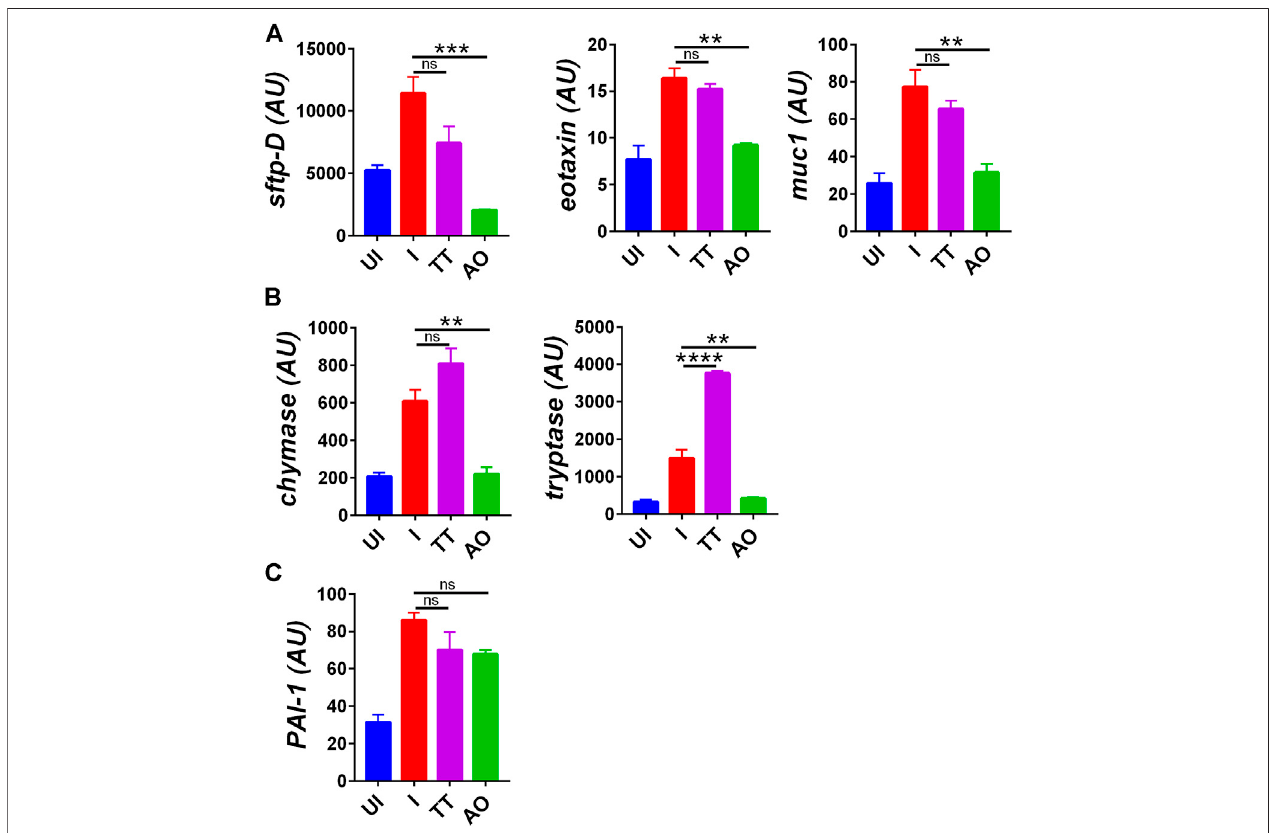
FIGURE 3 | Changes in mRNA expression of genes involved in lung injury upon AO or TT intranasal administration in hamsters infected with SARS-CoV2. Relative mRNAexpressionpro fi lingwascarriedoutinUI,I,TT,andAOlungsamplesfor (A) lunginjurygenes (B) mastcellactivationmarkers (C) thrombosisfactor.Mean ± SEM. ** p < 0.01, *** p < 0.001, **** p < 0.0001 (one-way